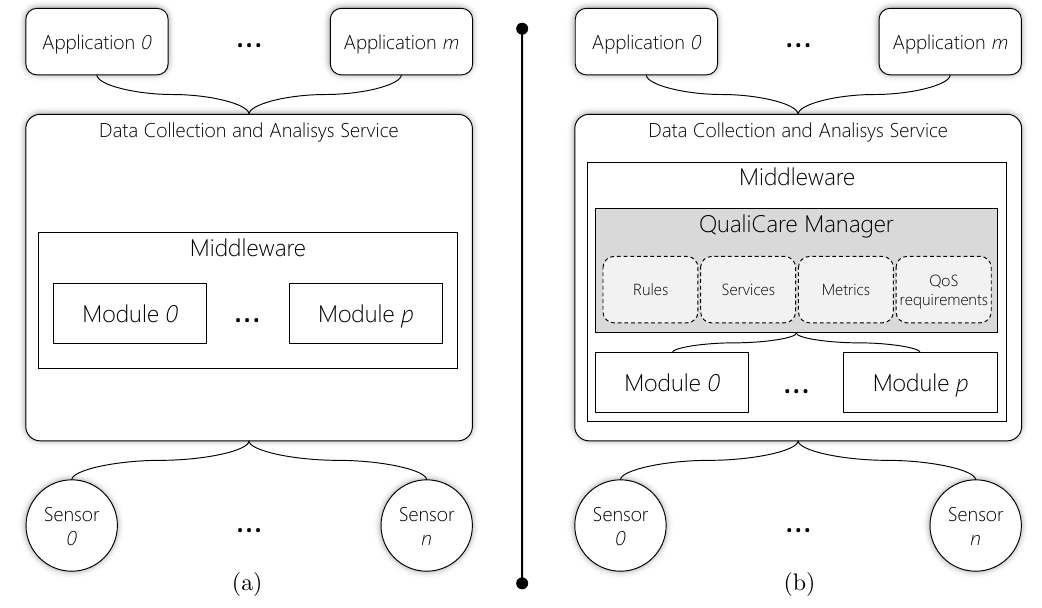
Figure 2. OR middleware general ideas: ( a ) default approaches; and ( b ) QualiCare main